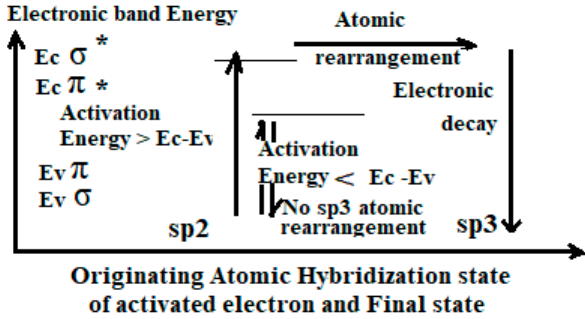
Figure 4. Principle of quantum electronic activated atomic rearrangement by S. Neuville [25].